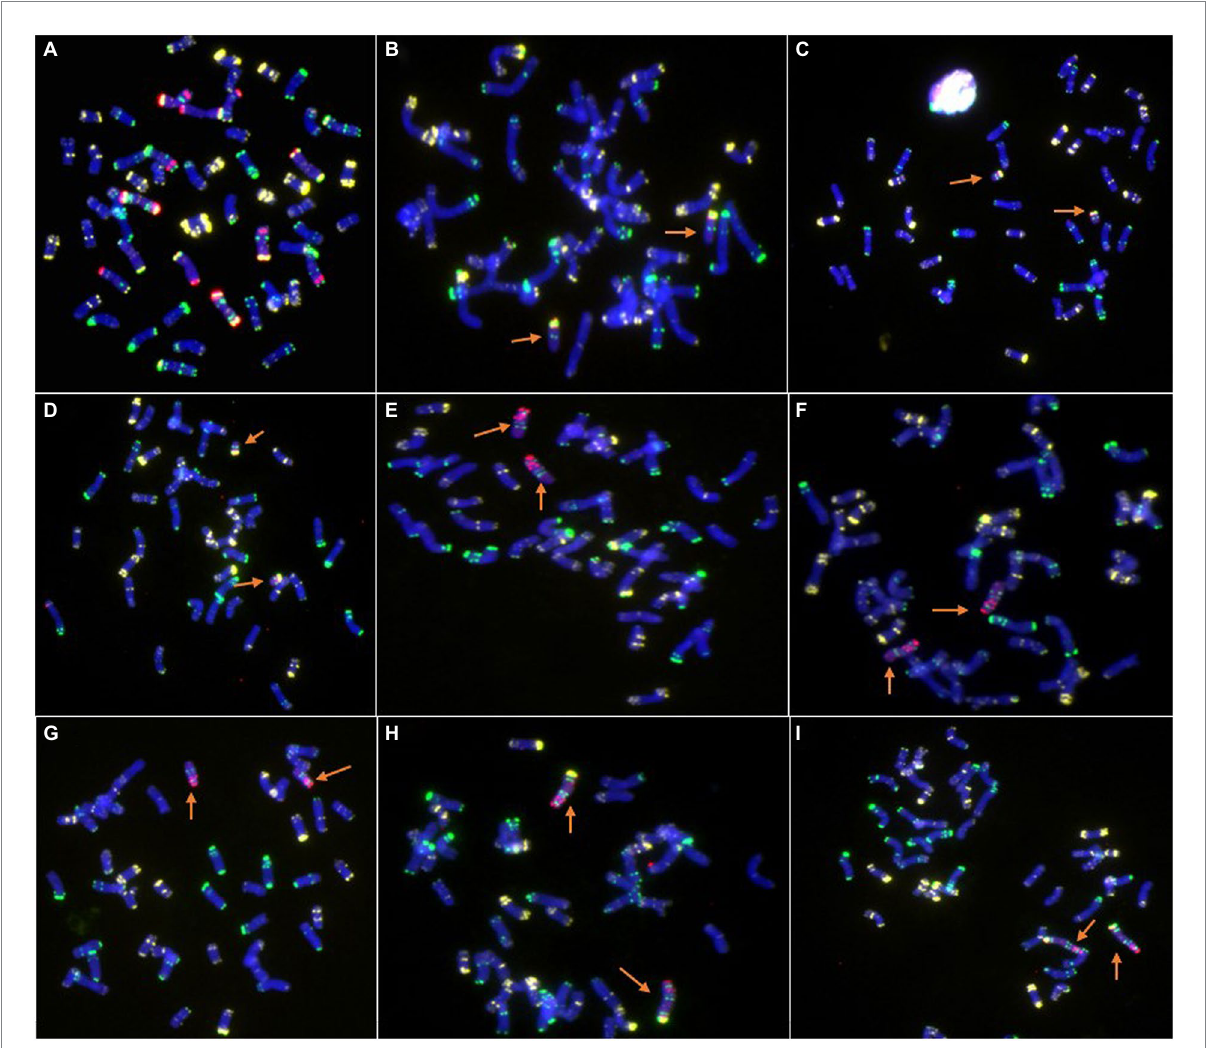
FIGURE 2 Cytogenetic analysis of new wheat-rye lines by ND-FISH. (A) Amphidiploid plants (2 n = 56, 21 ″ WW + 7 ″ RR). (B) 46-13-3, 6RS ditelosomic addition line. (C) 46-13-11, 6RS ditelosomic addition line. (D) 46-13-16, 6RS ditelosomic addition line. (E) 48-9-2, 6RL ditelosomic addition line. (F) 48-9-5, 6RL ditelosomic addition line. (G) 48-9-6, 6RL ditelosomic addition line. (H) 48-9-8, 6R disomic addition line. (I) 48-9-10, 6R disomic addition line. The arrows show the 6R, 6RL, or 6RS chromosomes. Oligo-pSc119.2-1: green; Oligo-pTa535-1: white; Oligo-Ku, Oligo-pSc200, and Oligo- pSc250: